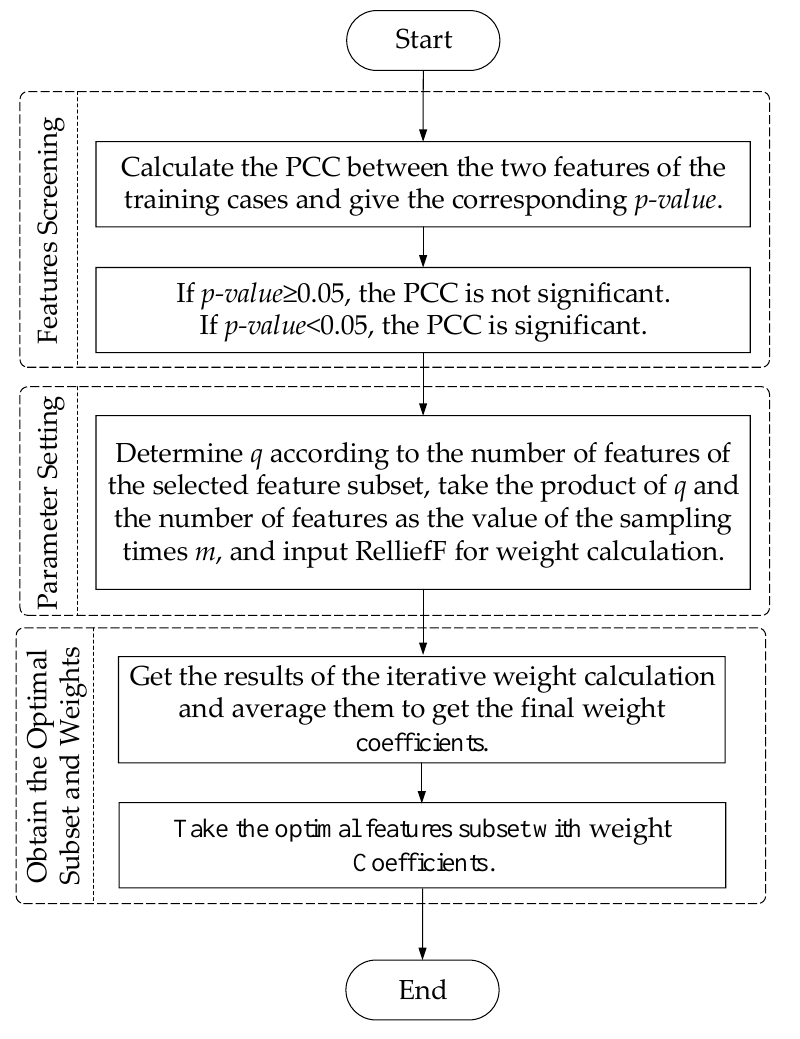
Figure 4. Steps of improved ReliefF algorithm.